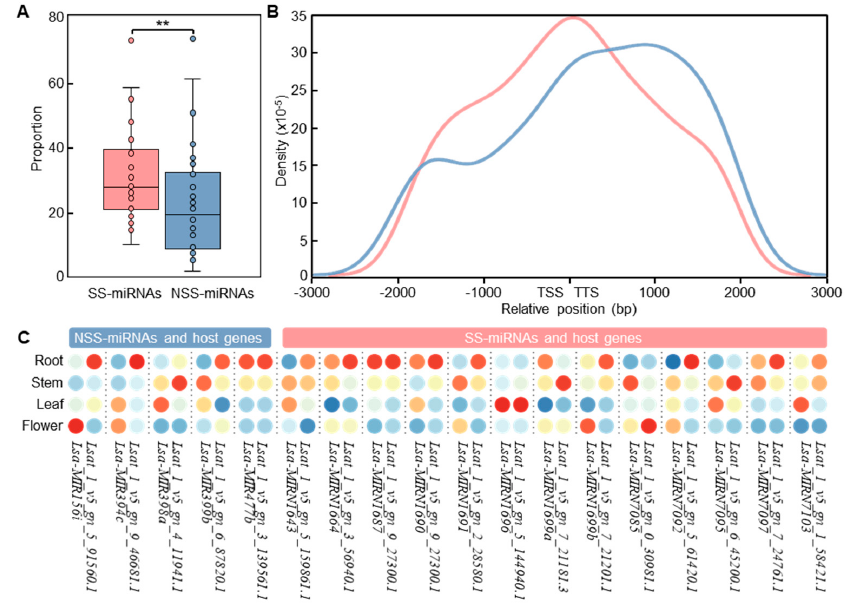
Figure 4. The locations of SS-miRNAs were closed to or within genes. ( A ) A box plot showing the proportion of SS-miRNAs and NSS-miRNAs with overlapped genes (** p < 0.01 by independent-samples t -test). The SS-miRNAs and NSS-miRNAs are colored in red and blue, respectively. ( B ) Density distribution of SS-miRNAs and NSS-miRNAs close to genes. TSS, transcription start site. TTS, transcription termination site. The SS-miRNAs and NSS-miRNAs are colored in red and blue, respectively. ( C ) The relative expression levels of SS-miRNAs, NSS-miRNAs, and overlapped host genes in four tissues of L. sativa are indicated with colors from blue to red. The colored circles from red to blue indicate the relative expression from high to low.